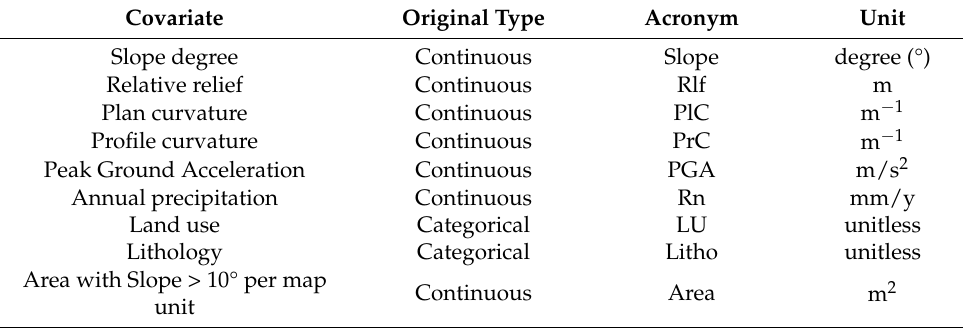
Table 1. Covariates used in the analysis, types, acronyms, and units.